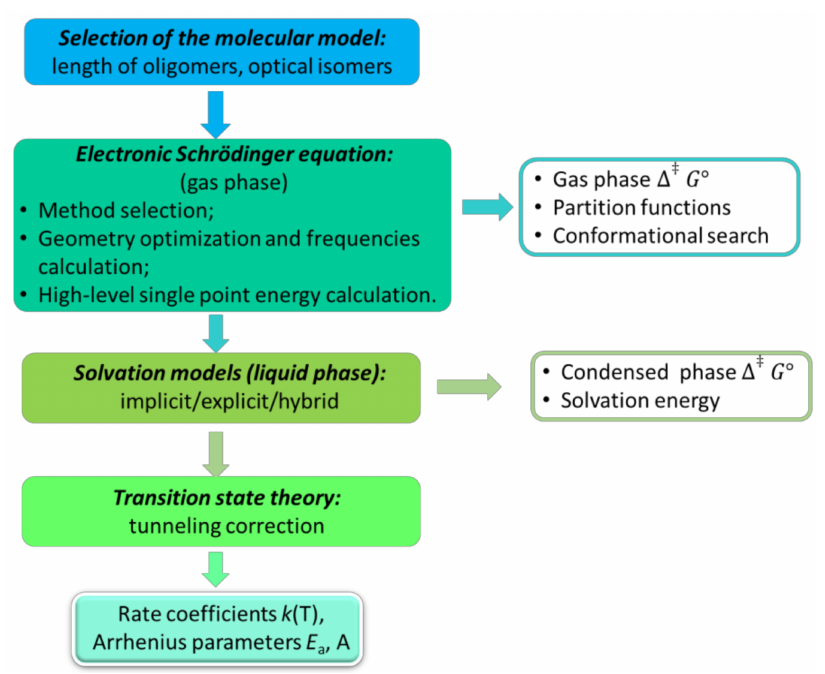
Figure 2. GeneralalgorithmforQCCtofinallyretrievekineticparameters; caseofpolymerization